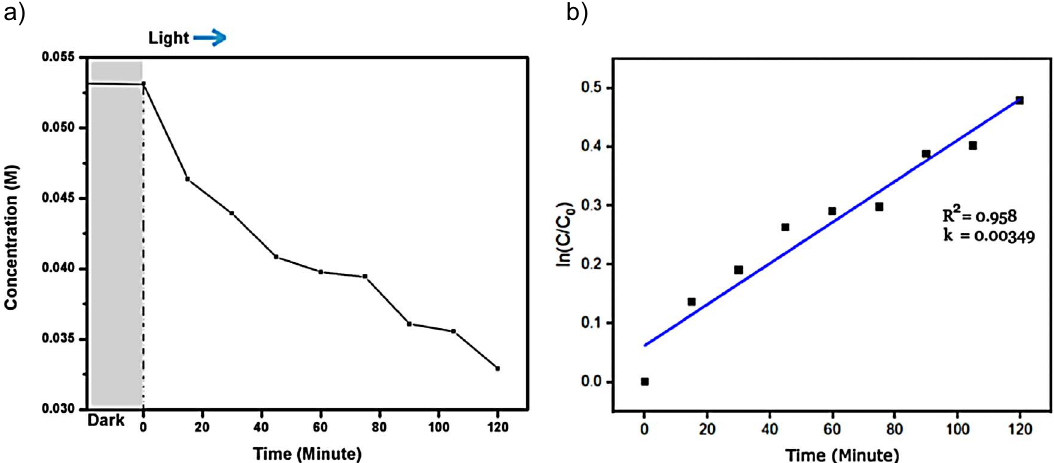
Figure 5. (a) Transient concentration pro fi le of phenol with incident irradiation of AM 1.5, and (b) Kinetic study of the photodegradation mechanism by nZVI